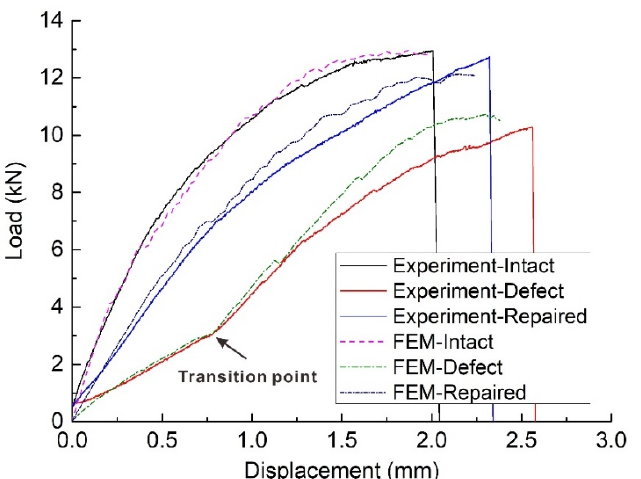
Figure 10. Comparison of the numerical and representative experimental load-displacement curves.